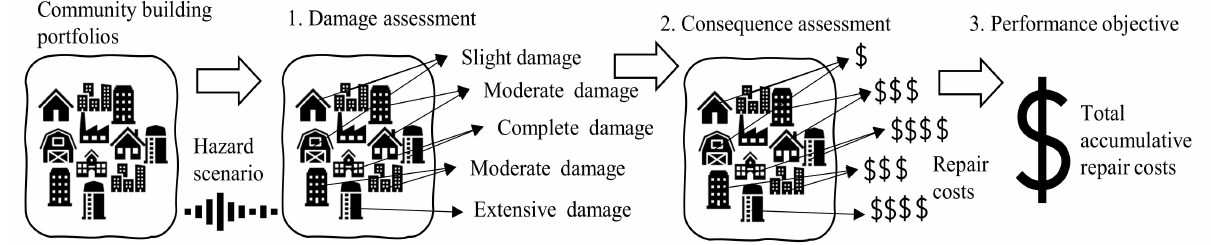
Figure 3. Performance objectives assessment of community building portfolio utilizing performance- based assessment